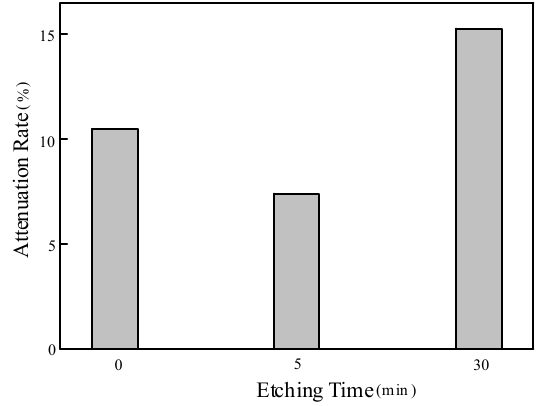
Figure 5. Surface potential decay rate of samples with different etching times.